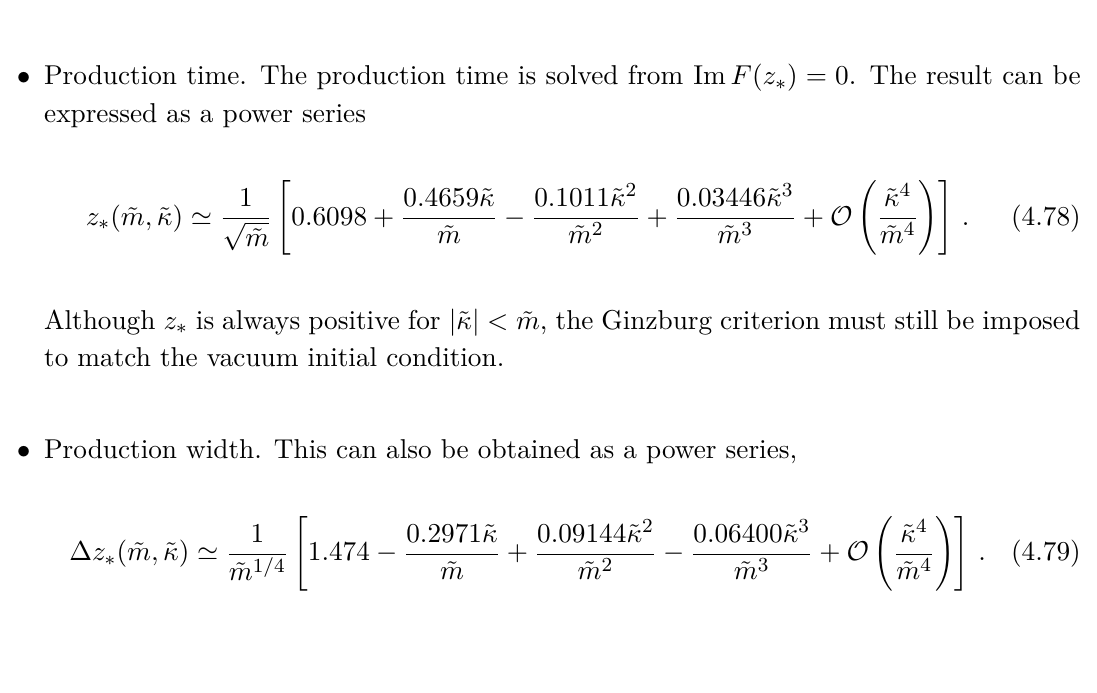
Figure 23 . The super-adiabatic singulant F ( z ) in matter-dominated era for ˜ κ = 0 . 05 (upper left panel) and ˜ κ = 0 . 099 (upper right panel), with the dimensionless mass ˜ m = 0 . 1 . The hue represents the phase arg F ( z ) while the brightness represents the modulus | F ( z ) | . In both panels, the dark red line is the Stokes line joining the complex turning points. The lower two panels show the Stokes multiplier S ( z ) corresponding to the parameters chosen